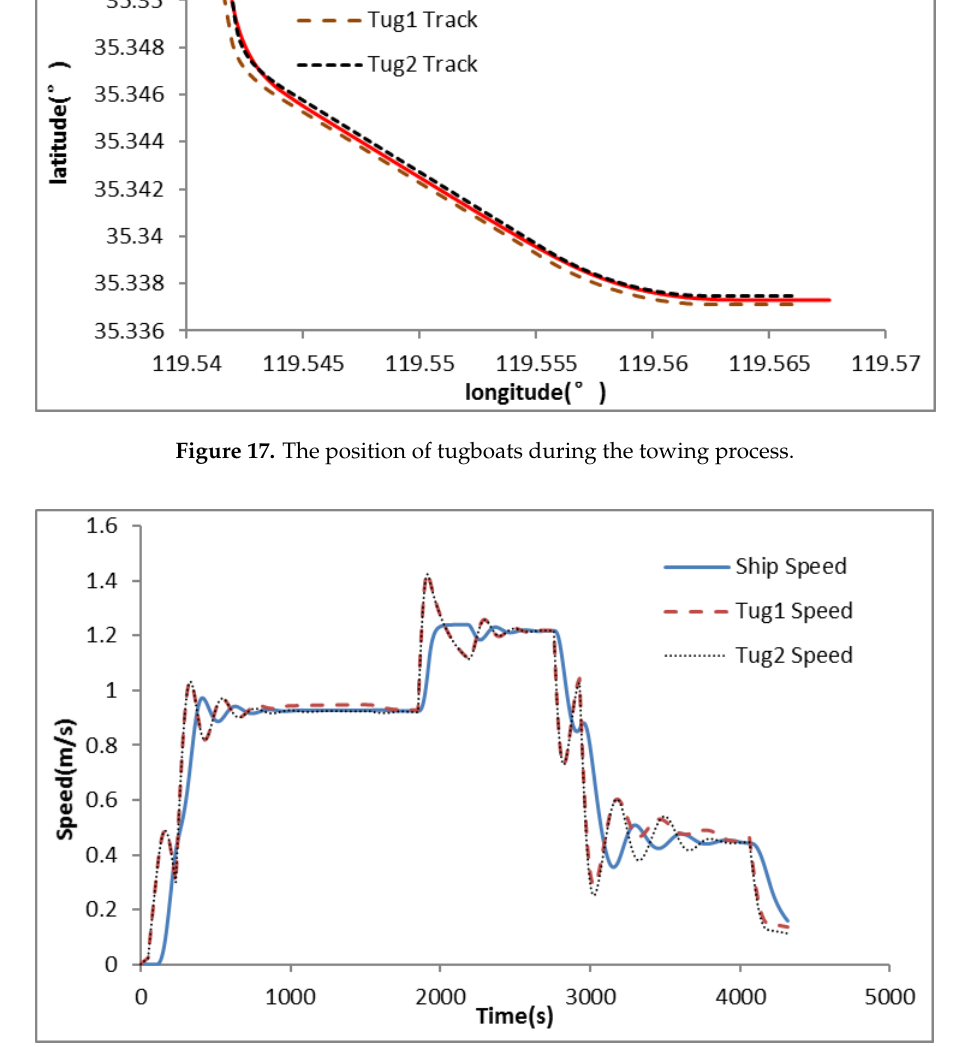
Figure 18. Speed change graph during towing.